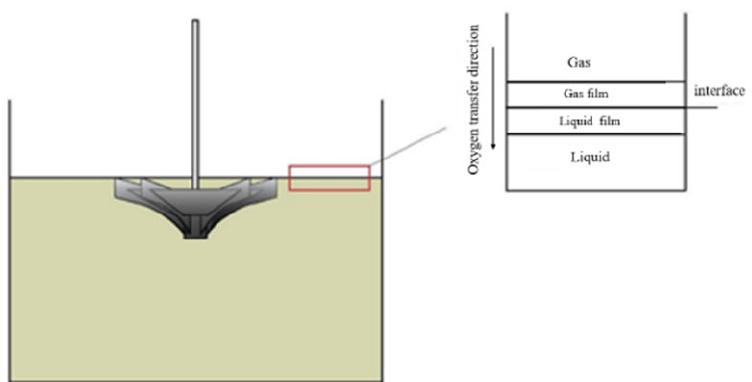
Figure 6. Schematic diagram of the double membrane theory .